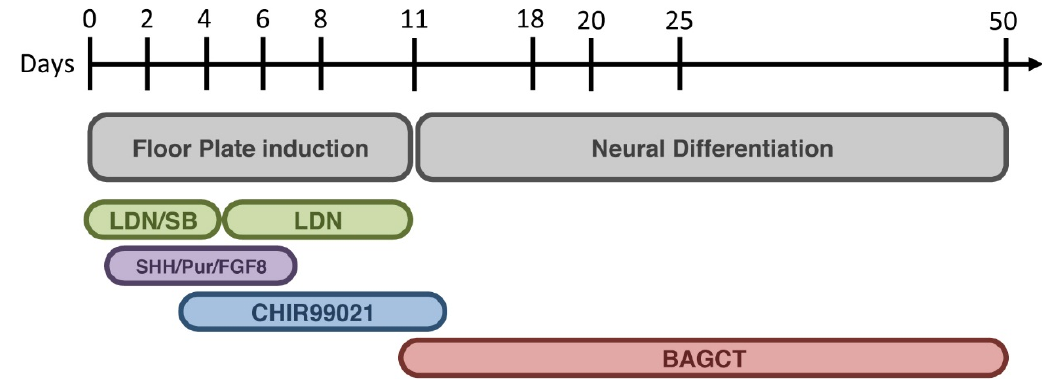
Figure 2. Schematic summary of the novel floor-plate A9 vmDAn differentiation protocol by Kriks [69]. The first stage illustrates floor-plate induction [70], with the appropriate modification in order to reach a more specialized A9 midbrain DA neuronal identity. Exposure to LDN (LDN193189) and SB (SB431542) triggers the Dual-SMAD inhibition. Purmorphamine (Pur), which activates Sonic Hedgehog (SHH) signaling, together with SHH and FGF8 is not sufficient to trigger a selective enrichment of midbrain DA precursors. However, SHH/Pur/FGF8 in combination with exposure to CHIR99021 (a potent GSK3 β inhibitor known to strongly activate WNT signaling) allows for a complete enrichment of DA precursors with A9 midbrain identity, by inducing the expression of FOXA2 and LMX1A. Neural differentiation and maturation is achieved through the use of a cocktail of neurotrophic factors BAGCT (BDNF + ascorbic acid + GDNF + dbcAMP + TGF β